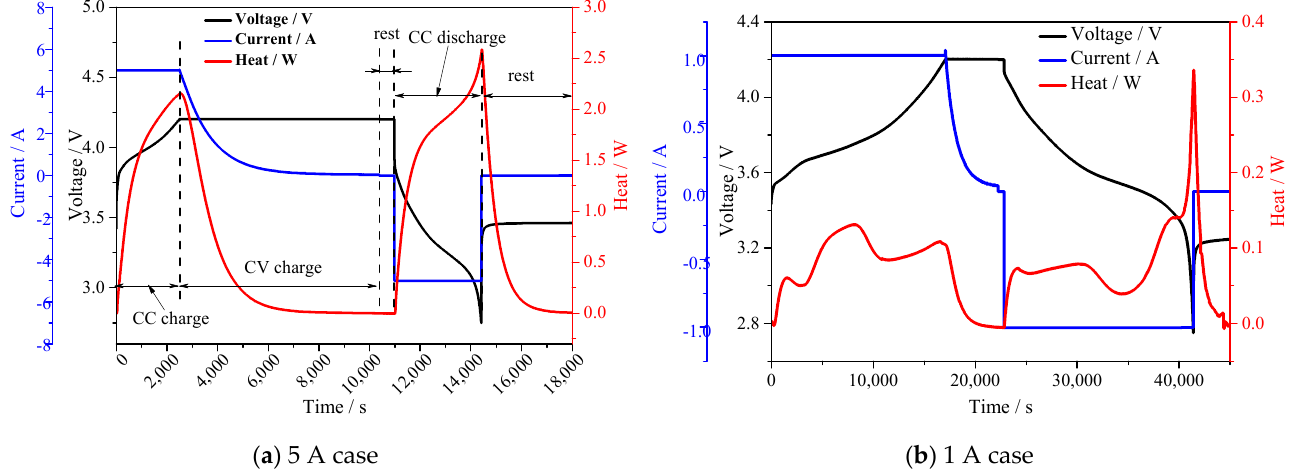
Figure 1. The functions of heat generation rate, operating current, and voltage changing with time, increasing under 25 °C.